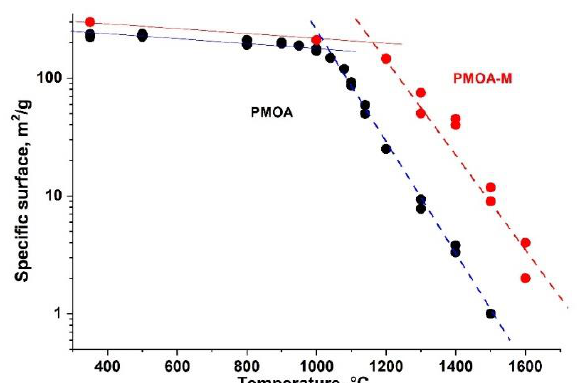
Figure 7. Specific surface area of pure PMOA and PMOA-M at different temperatures in isochronous 4h annealing.